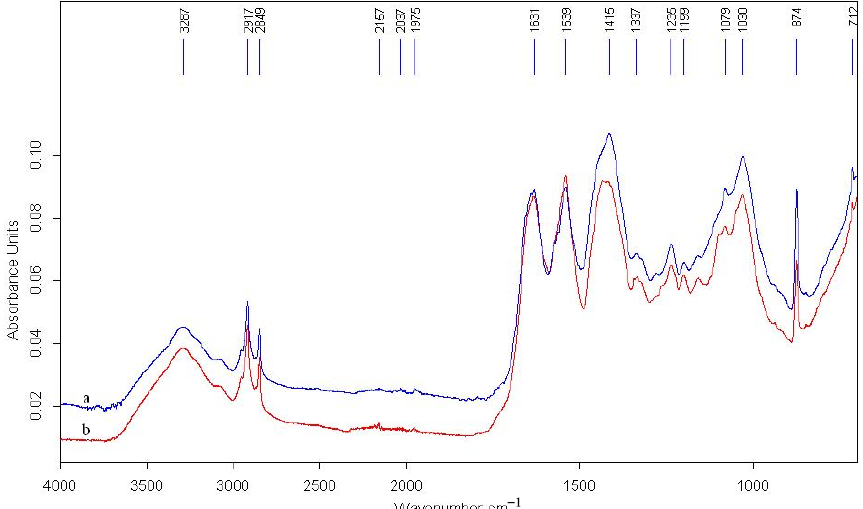
Figure 11. Fourier-transform infrared (FTIR) spectra on the support of the two documents: ( a ) S1-SD; ( b ) S2-S.